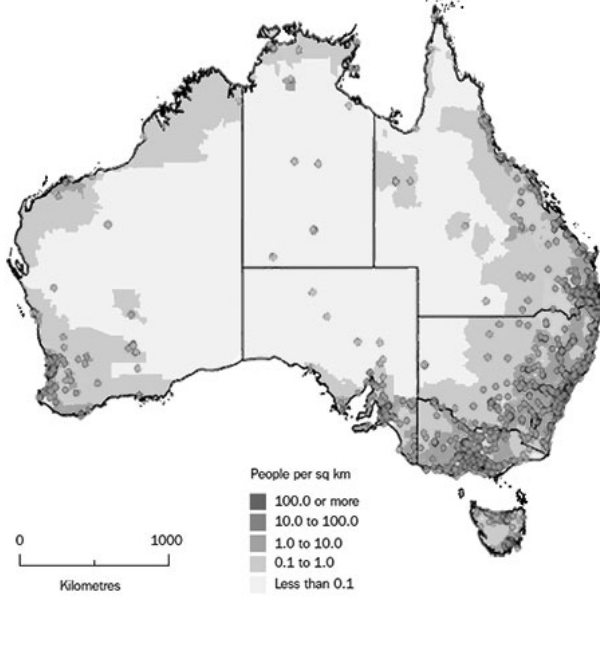
Figure 1. Distribution of women aged 18-23 years recruited using the Internet across Australia (N=17,069). Each dot represents at least 1 woman. Figure adapted from the Regional Population Growth, Australia (catalogue